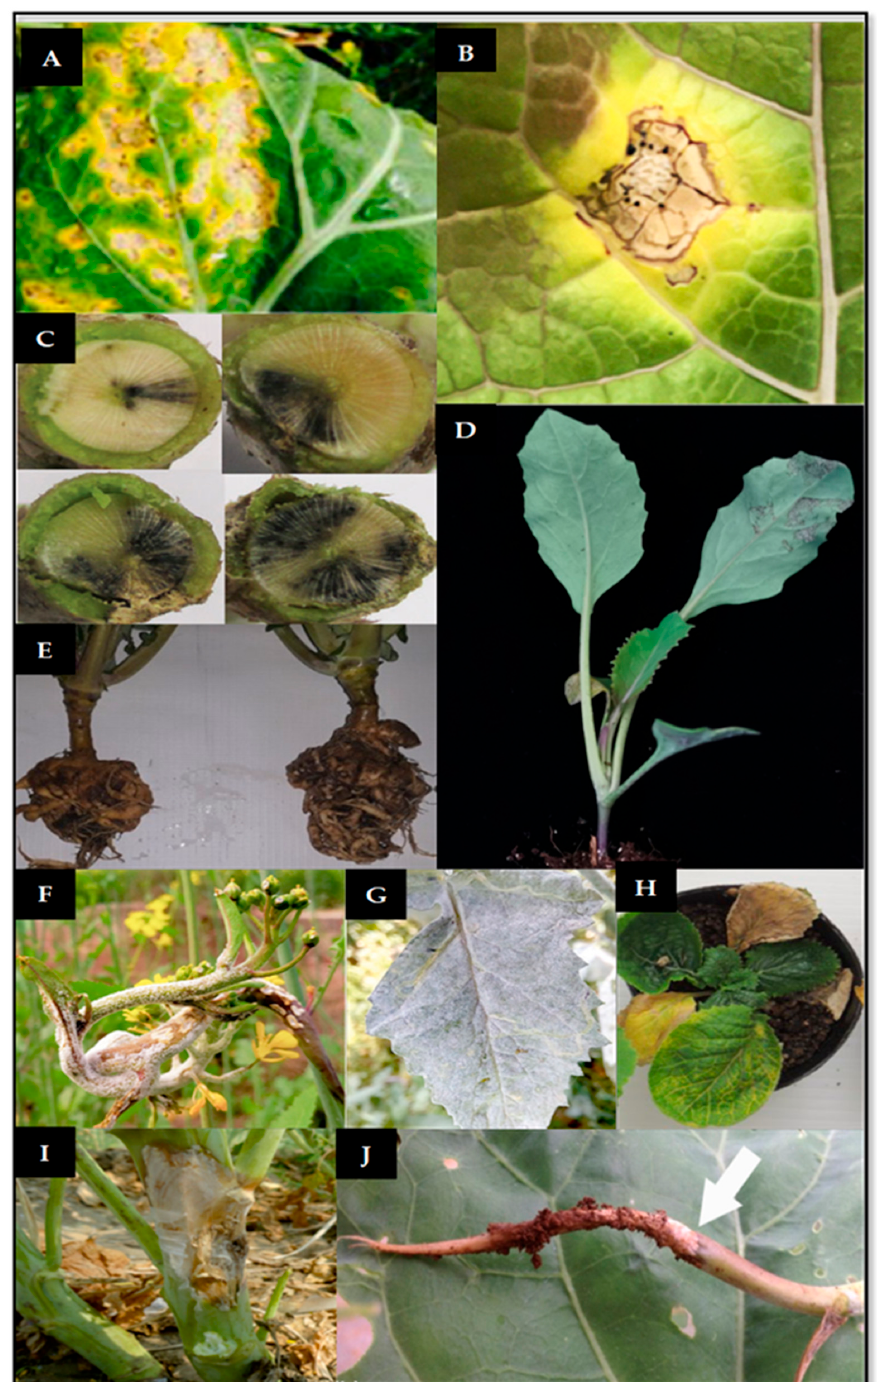
Figure 1. Representative symptoms of the main fungal diseases affecting Brassicaceae. ( A ) White leaf spot by Neopseudocercosporella capsellae [105]. ( B ) Leaf spot by Alternaria brassicaea [106]. ( C ) Blackleg by Leptosphaeria maculans [66]. ( D ) Downey mildew by Perenospora parasitica [11]. ( E ) Clubroot by Plasmodiophora brassicae [107]. ( F ) White rust by Albugo candida [108]. ( G ) Powdery mil- dew by Erysiphe cruciferarum [108]. ( H ) Fusarium yellows by Fusarium oxysporum f. sp . conglutinans [109]. ( I ) Sclerotinia stem rot by Sclerotinia sclerotiorum [108]. ( J ) Wirestem by Rhizoctonia solani [110].